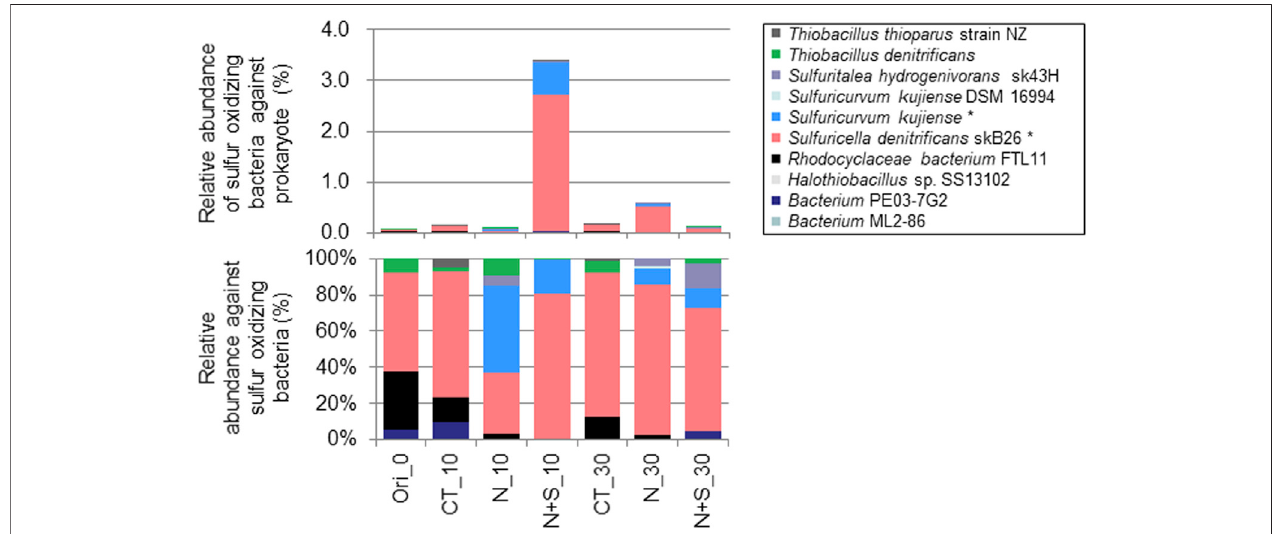
FIGURE 8 | Comparison of relative abundances of sulfur-oxidizing bacteria between treatments during the long-term incubation experiment in the I2 soil. Ori, original soil before incubation; CT, control; N, N treatment; N + S, N + S treatment. 0, 10, and 30 indicate the number of days after the start of incubation. The fi gure legend * indicates signi fi cant differences among treatments detected using Kruskal – Wallis test ( p < 0.05), but no signi fi cant differences were detected any pairs of the data groups by Steel-Dwass test.